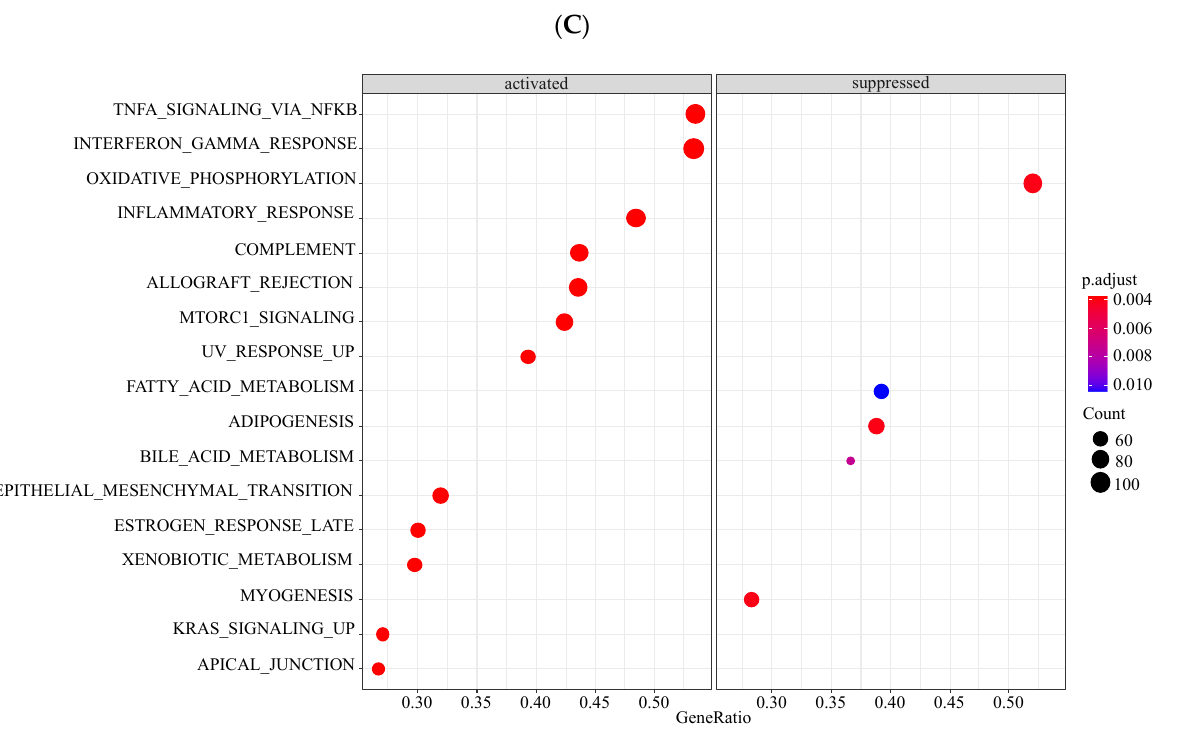
Figure 7. GSEA results of three key genes. ( A ) Enrichment plots of LYVE1 . ( B ) Enrichment plots of MAFB . ( C ) Enrichment plots of MT1M . Oxidative phosphorylation pathway ranked first among the suppressed pathways no matter in LYVE1 , MAFB , or MT1M , whereas TNF α -NF κ B, IFN γ response, and inflammatory response pathways ranked the top three among the activated